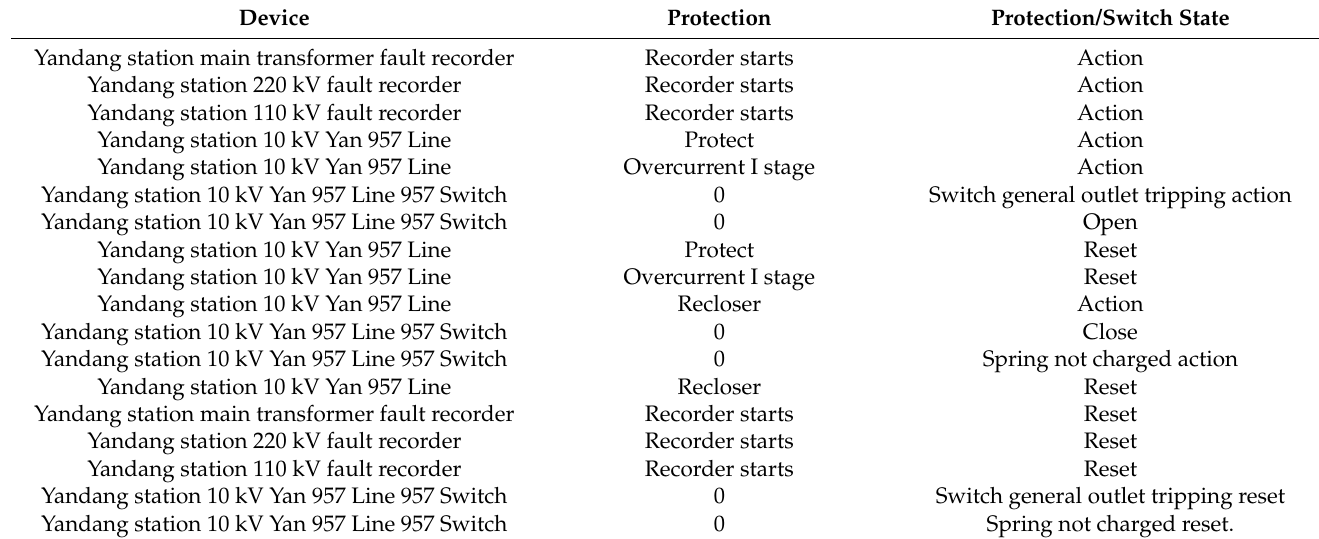
Table 1. Alarm information